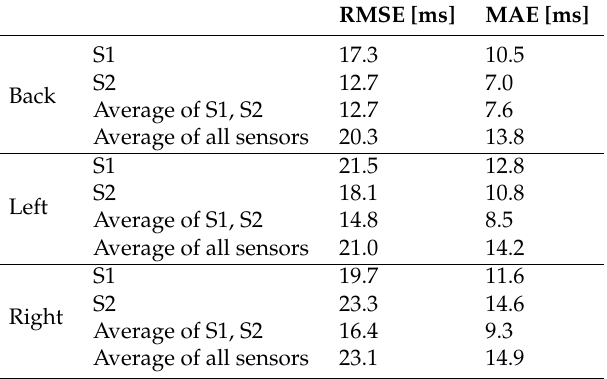
Table 3. Results of